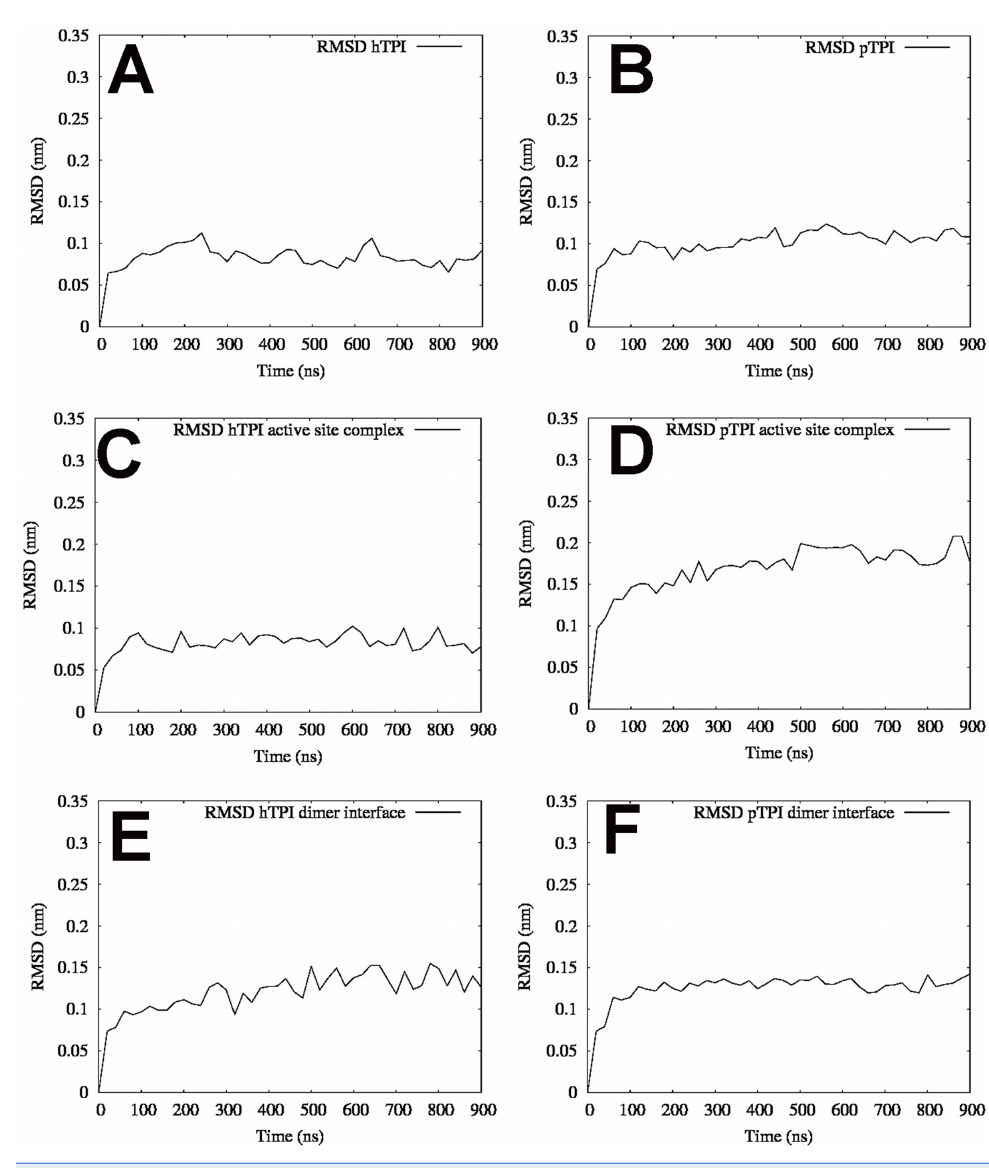
Figure 4 Root-mean-square deviation. Time evolution of root-mean-square deviations of backbone atoms relative initial conformation for sulfaE/TPI complexes (A) Free-hTPI (B) Free-pTPI (C) hTPI active site complex (D) pTPI active site complex. (E) hTPI dimer interface complex. (F) pTPI-dimer interface